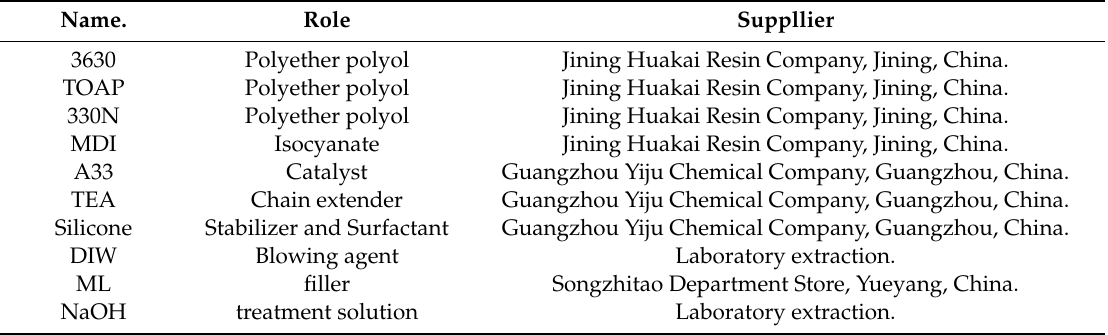
Table 1. Major information of the material.